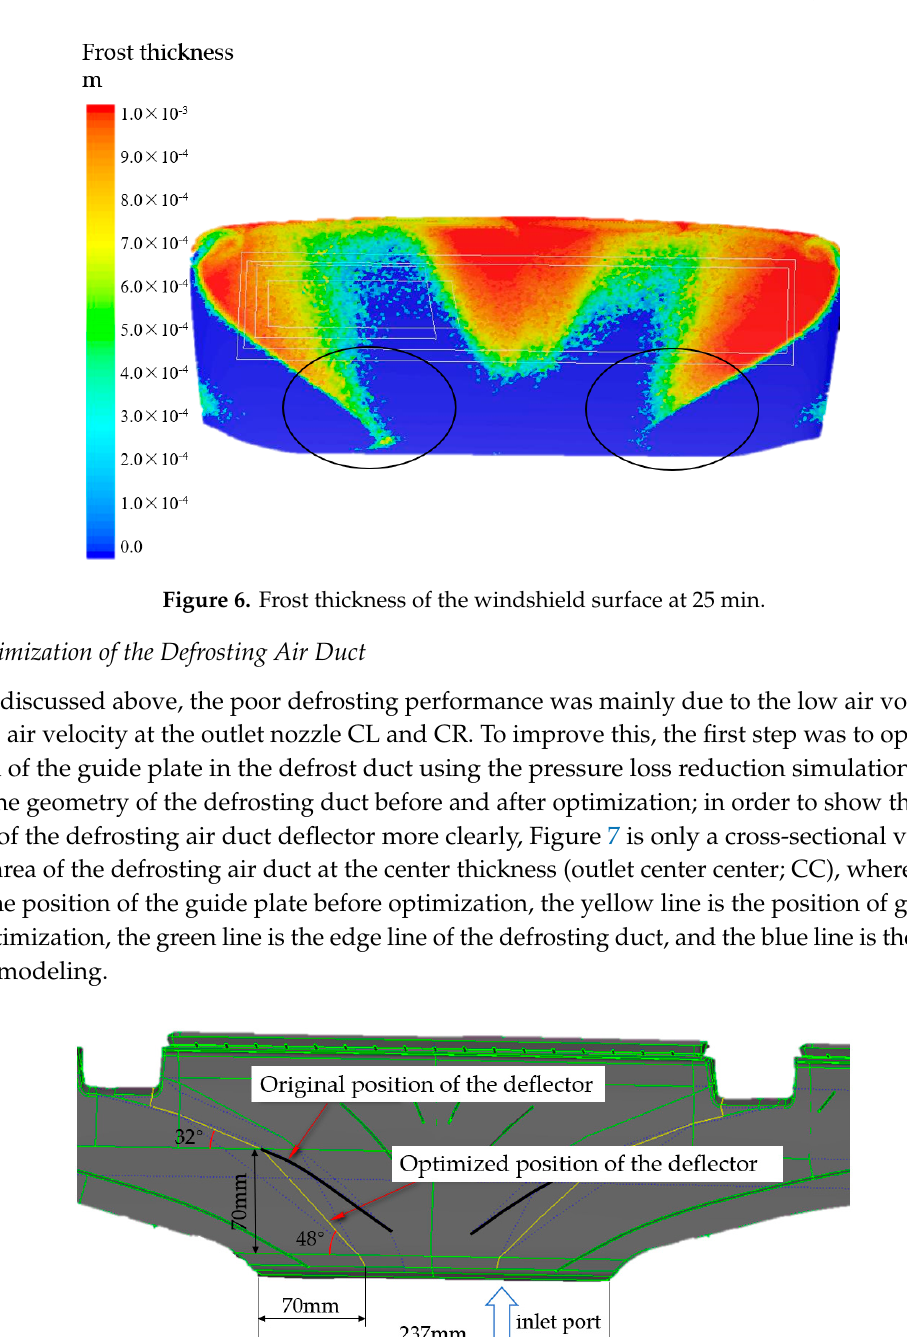
Figure 8. Comparison of pressure loss before and after optimization. Figure 9 shows the distribution of frost thickness on the glass surface after defrosting for 25 min in the optimized duct. It shows that 89% of the windshield was defrosted. However, the defrosting effect of the side window glass was still not ideal. After 25 min of defrosting, the defrosting area of the side window was about 80%. This may have been caused by the low air flow rate and velocity distribution of the left hand (LH) and right hand (RH) defrosting air ducts, which requires further optimization of the defrosting air duct.